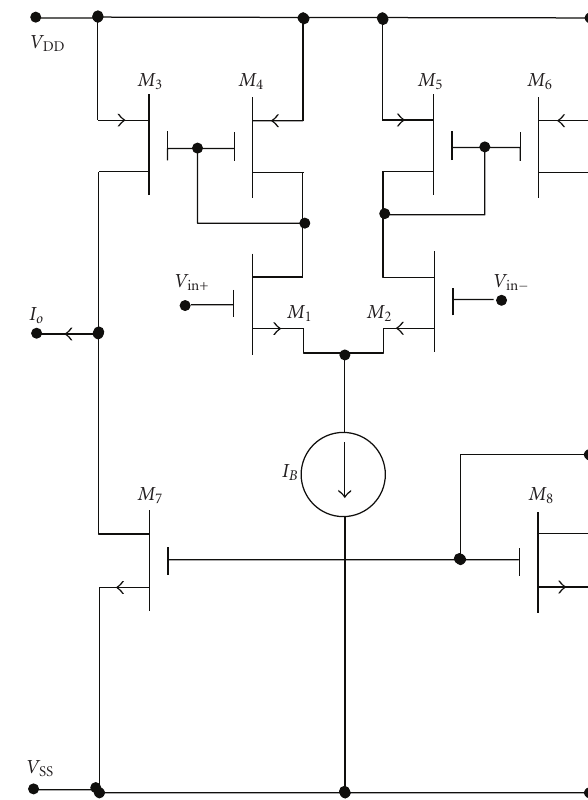
Figure 17: CMOS implementation of